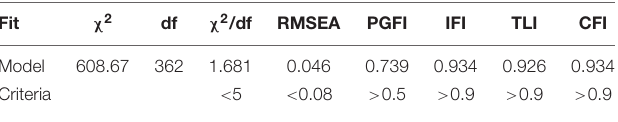
TABLE 7 | Fitting index of regional soft environment measurement model ( N =